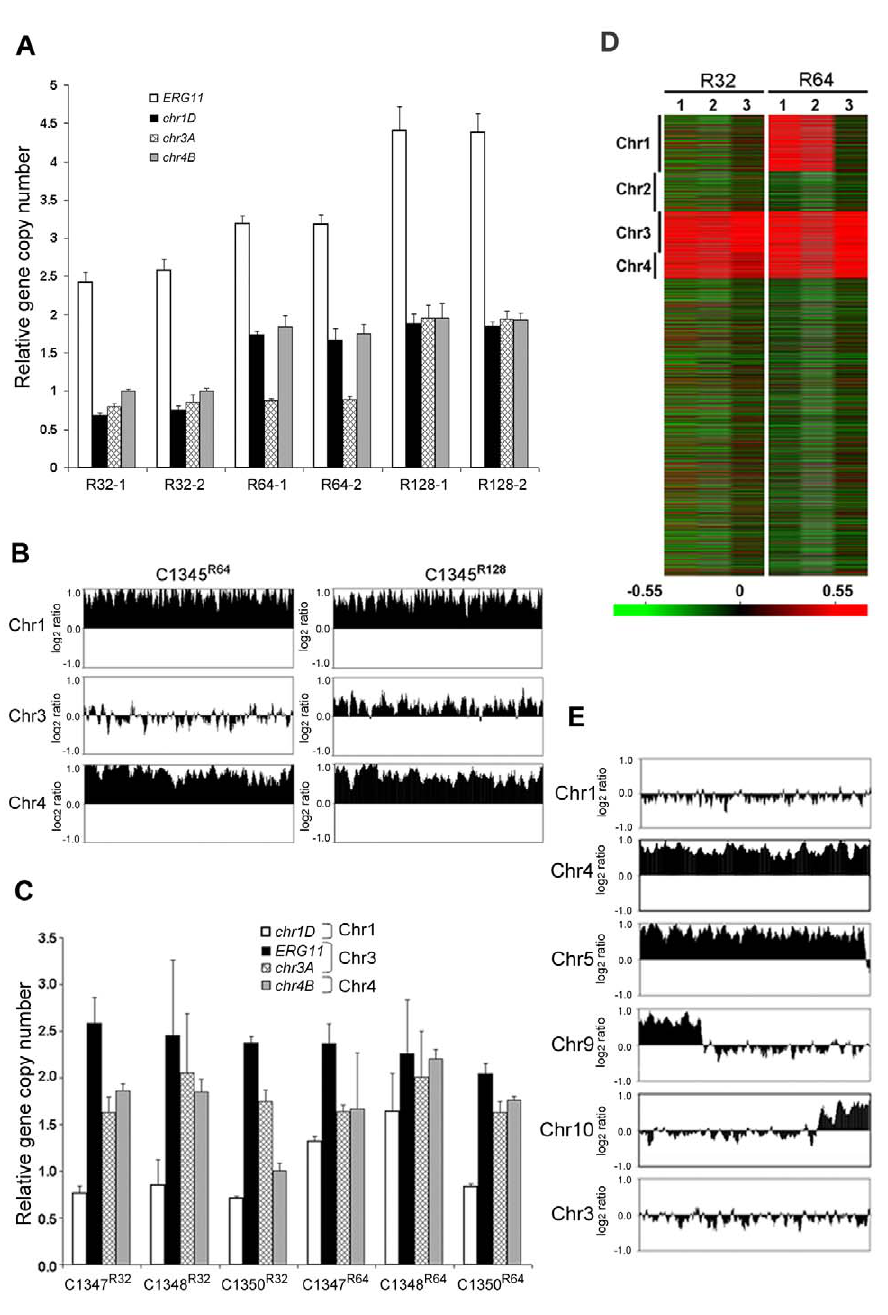
Figure 6. The importance of ERG11 and AFR1 in Chr1 duplication. ( A ) Gene duplication patterns in C1345 derived strains. Gene copy number was determined by qPCR in resistant colonies derived from C1345 which contains two copies of ERG11 , one on Chr1 and the other on Chr3. Two different colonies resistant to FLC 32, 64 and 128 m g/ml are shown respectively. Gene copy number was quantified by measuring four probes ( ERG11 = chr1A , chr1D , chr3A and chr4B ) located on Chr1, 3 and 4, respectively, in comparison to the control probe ( chr5A ) on Chr5. ( B ) CGH plots of Chr1, 3, and 4 for C1345 R64 and C1345 R128 that tolerate 64 and 128 m g/ml FLC, respectively. Only the chromosomes involved in duplication are shown. ( C ) Gene copy number was determined by qPCR in resistant colonies derived from three independent transformants (C1347, C1348, and C1350), each with a single copy of ERG11 on Chr3. Strains resistant to 32 and 64 m g/ml FLC are shown. The probes located on Chr1, 3, and 4 were compared to the control probe ( chr5A ) on Chr5. ( D ) Heat map of CGH results: lanes 1–3 represent the CGH array of three independent strains, C1347, C1348, and C1350, resistant at 32 and 64 m g/ml FLC, respectively. The relative copy number is represented by color as shown in the bar. Red indicates that the copy number of the genes is close to 2. ( E ) CGH plots of Chr1, 4, 5, 9, 10, and 3 for the C1371 ( afr1 D R1 ) strain resistant at 1 m g/ml of FLC. doi:10.1371/journal.ppat.1000848.g006 Chr1. Single colony qPCR of these three strains supported the and C1350 resistant to 64 m g/ml FLC (Figure 6D). C1347 R64 and CGH results although the copy number of chr1D in C1347 R64 was C1348 R64 displayed disomies of Chr1, Chr3 and Chr4 while C1350 R64 showed duplication only in Chr3 and Chr4 but not in only 1.32 ( 6 0.05), suggesting that Chr1 amplification occurred in